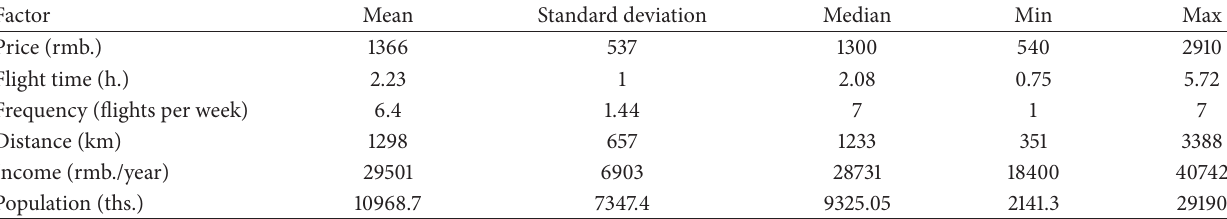
Table 2: Summary statistics (Chinese